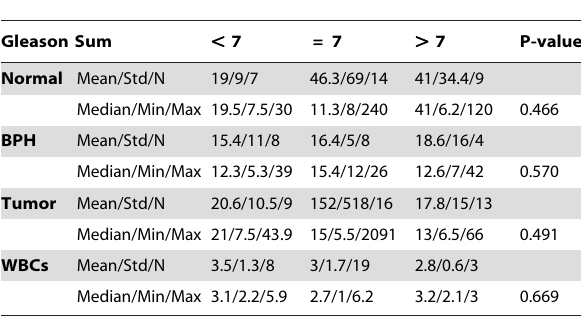
Table 4. Comparison of mtDNA content in normal, BPH, tumor, and WBCs between different Gleason grades (Gleason Sum).